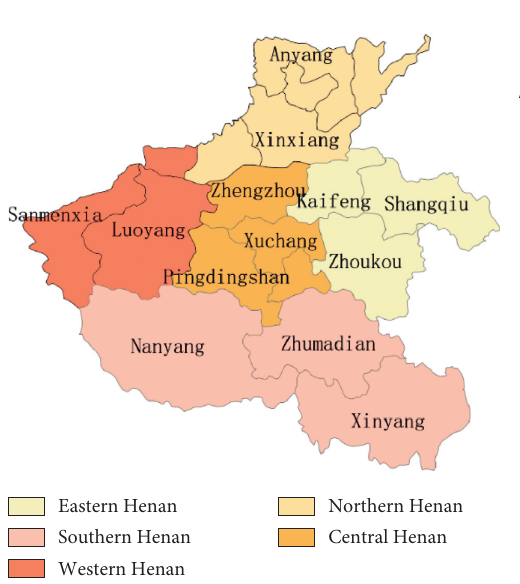
Figure 1: Map of 13 cities in Henan